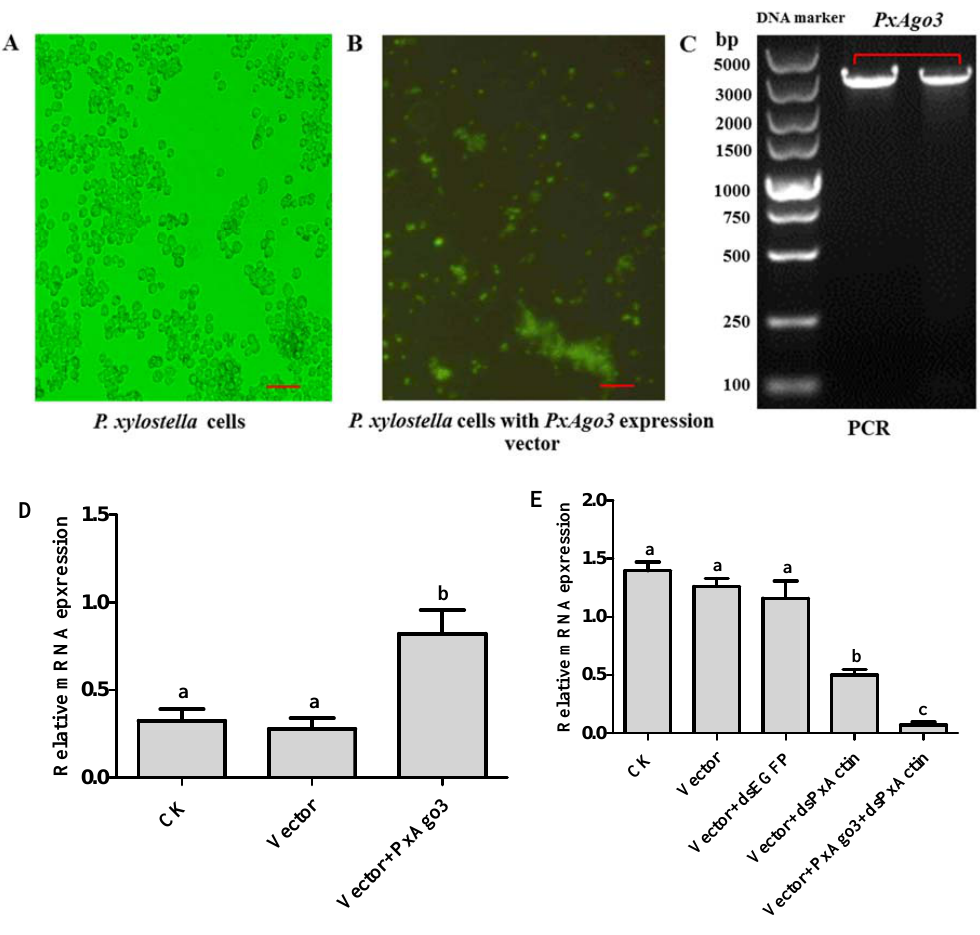
Figure 6. Effects of PxAgo3 overexpression on PxActin suppression in P. xylostella cells. ( A ) P. xylostella cells; ( B ) the phenotypical expression of PxAgo3 expression vector into P. xylostella cells. Scale Bar: 100 μ m; ( C ) PCR product of PxAgo3 using P. xylostella cells with PxAgo3 expression vector as the template; ( D ) the expression level of PxAgo3 in P. xylostella cells; ( E ) the expression level of PxActin in P. xylostella cells. Different lowercase letters represent significant differences among treatments (Tukey’s post hoc test, p < 0.05)